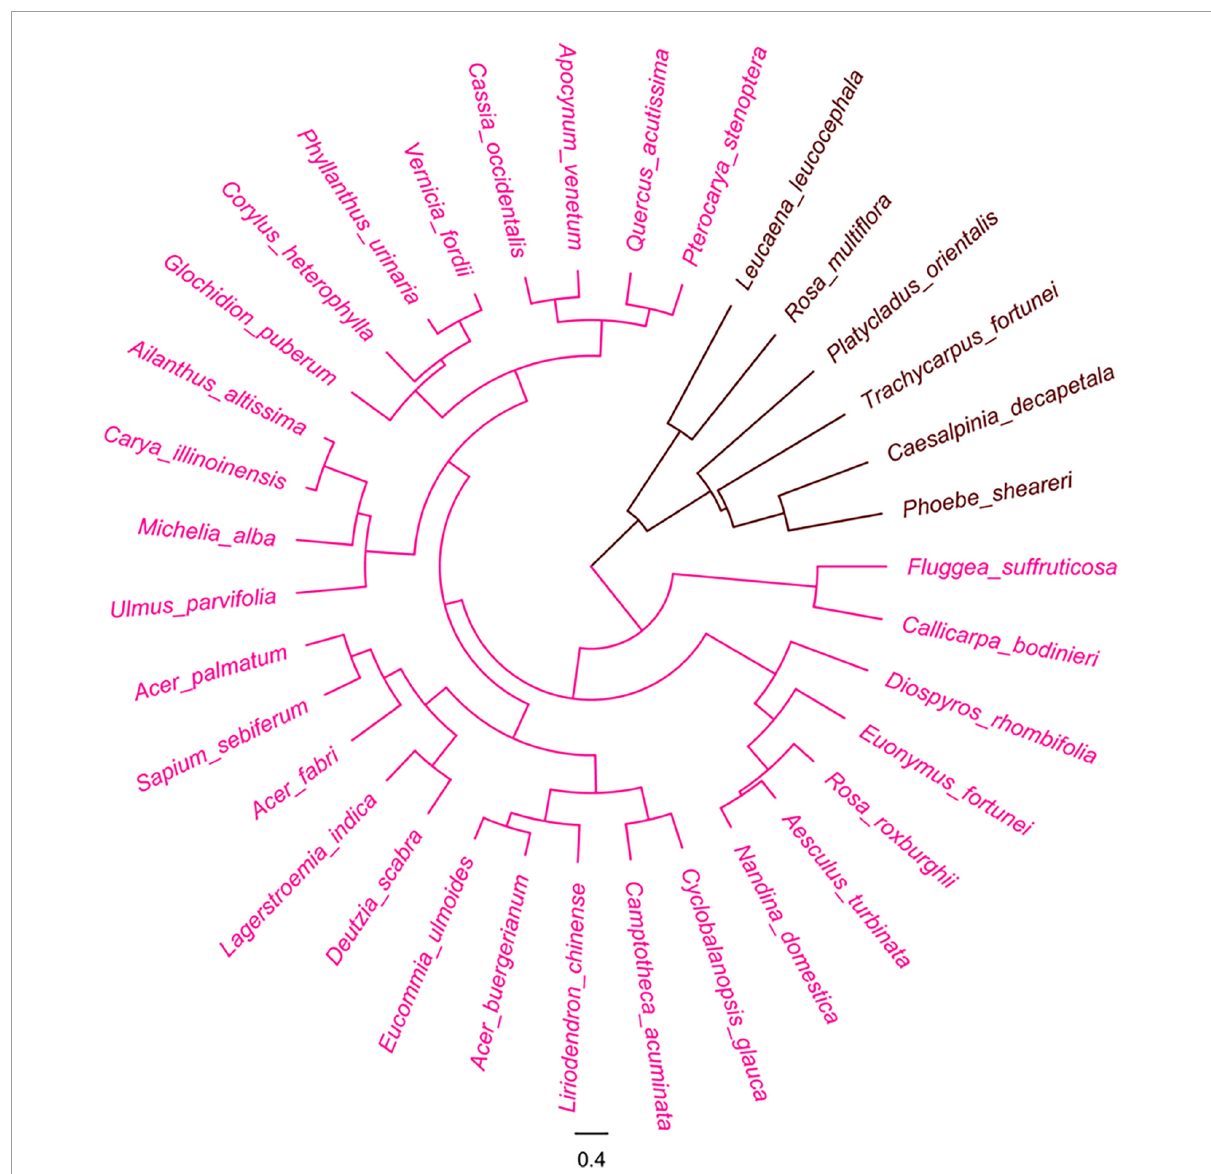
FIGURE4 Cluster analysis of invasive plants based on the color of pre- and post-stained seeds/fruits. Red color indicates visibility of stained seeds from visible to invisible.